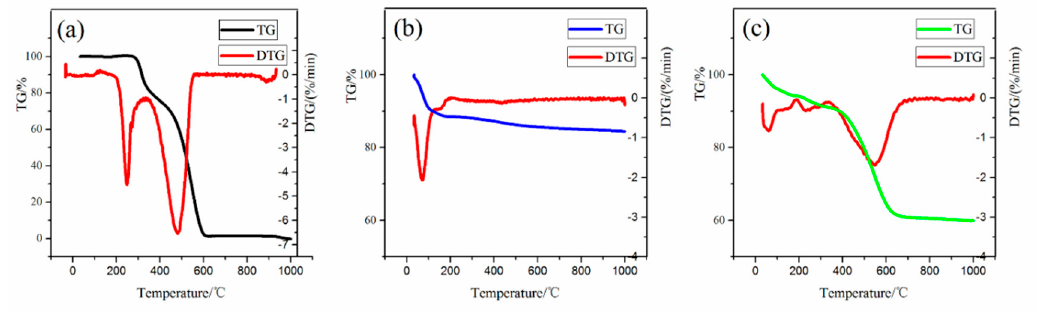
Figure 4. The TG-DTG (Thermogravimetric-Derivative Thermogravimetric) curves of ( a ) RSV, ( b ) silica aerogel and ( c ) RLSA.